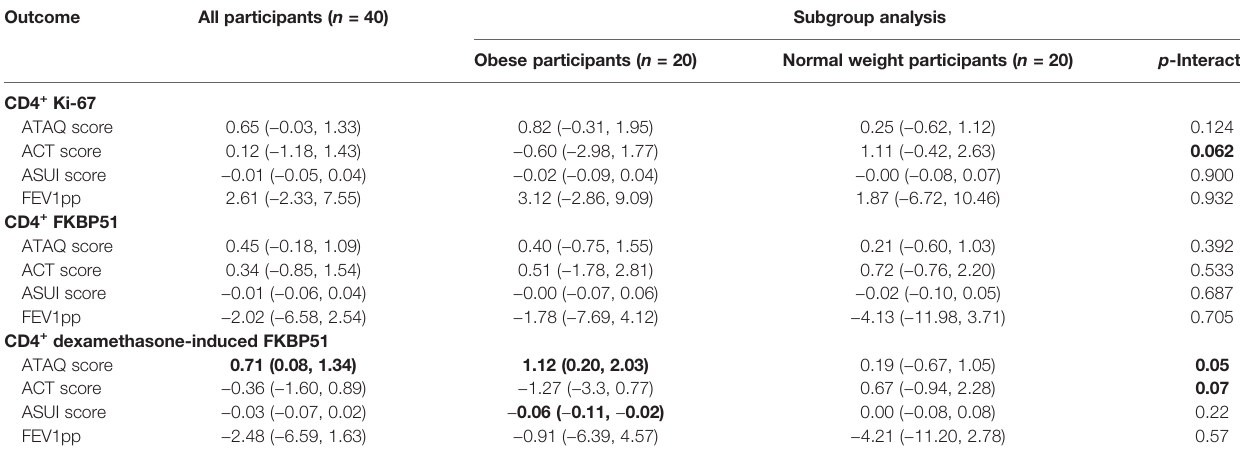
TABLE 2 | Beta (95% CI) per standard deviation of CD4 + Ki-67, FKBP51, and dexamethasone-induced FKBP51 expression to asthma control and lung function in obese and normal weight participants with asthma.